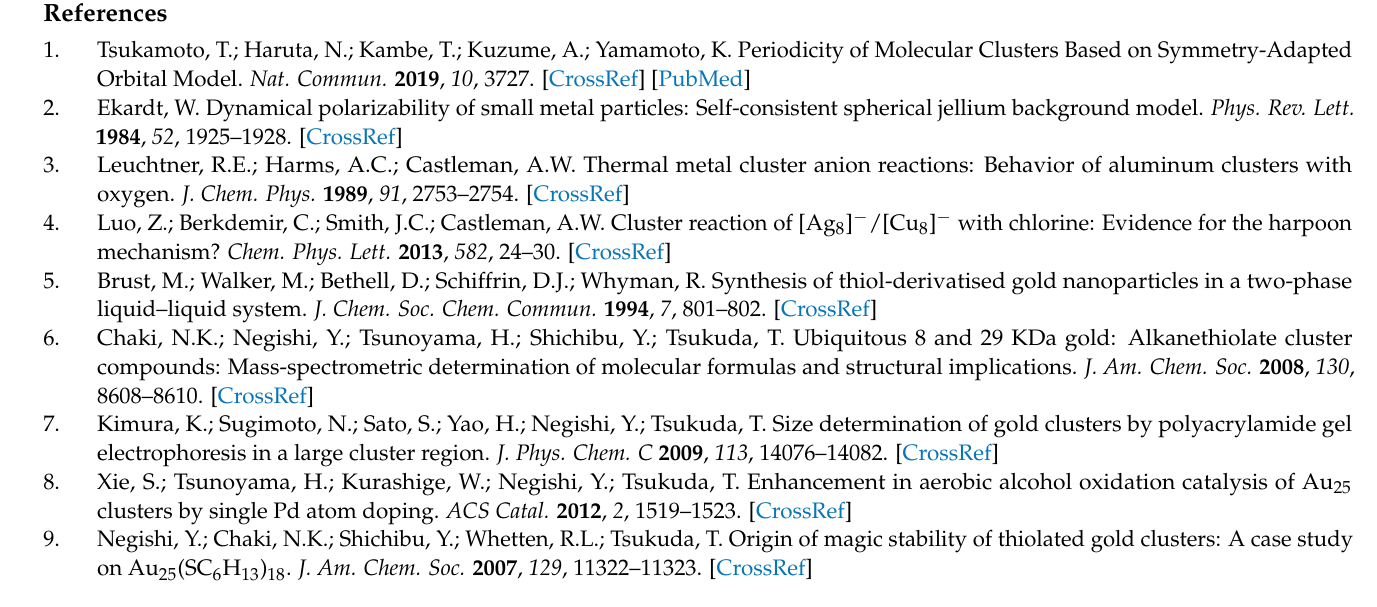
current is 1 µ A. Figure S5. MALDI-TOF-MS spectra after 2 h of the Au 25 PET 18 synthesis reaction with TPM G4. Figure S6. Synthetic procedure of Au 25 PET 18 cluster not using TPM G4. Note: main product is Au nanoparticle. The concentration of AuCl 3 was the same as when synthesized using TPM G4. In the presence of dendrimers, the equivalent of 25 equivalents of AuCl 3 is 45 µ M. Figure S7. MALDI-TOF-MS spectra after 2 h of the Au 25 PET 18 synthesis reaction without TPM G4. Figure S8. Comparison during synthesis of Au 25 PET 18 with and without TPM G4. A significant color change is observed immediately after reduction. Figure S9. Image of the effect of dendrimer during Au 25 PET 18 synthesis and its main and byproducts. Figure S10. The image of the stable structures of PdAu 24 PET 18 (note: draw a figure with reference to the previous report [76]). Figure S11. ( a ) STEM image, ( b ) STEM/EDS mapping image and ( c ) EDS spectrum (purple: whole image, gray: blank area) of PdAu 24 PET 18 . Figure S12. ( a ) Synthetic scheme of thiol-protected Au clusters blended with different elements (Pt), ( b ) the image of the possible structures of PtAu 24 PET 18 (note: draw a figure with reference to the previous report [20],), ( c ) MS spectrum of PtAu 24 SR 18 . Figure S13. ( a ) STEM image, ( b ) STEM/EDS mapping image and (c,d) EDS spectrum (light blue: whole image, gray: blank area) of PtAu 24 PET 18 . Figure S14. A comparison of the simulated values (light blue: PtAu 24 PET 18 and yellow: Au 25 PET 18 ) and the measured value of PtAu 24 PET 18